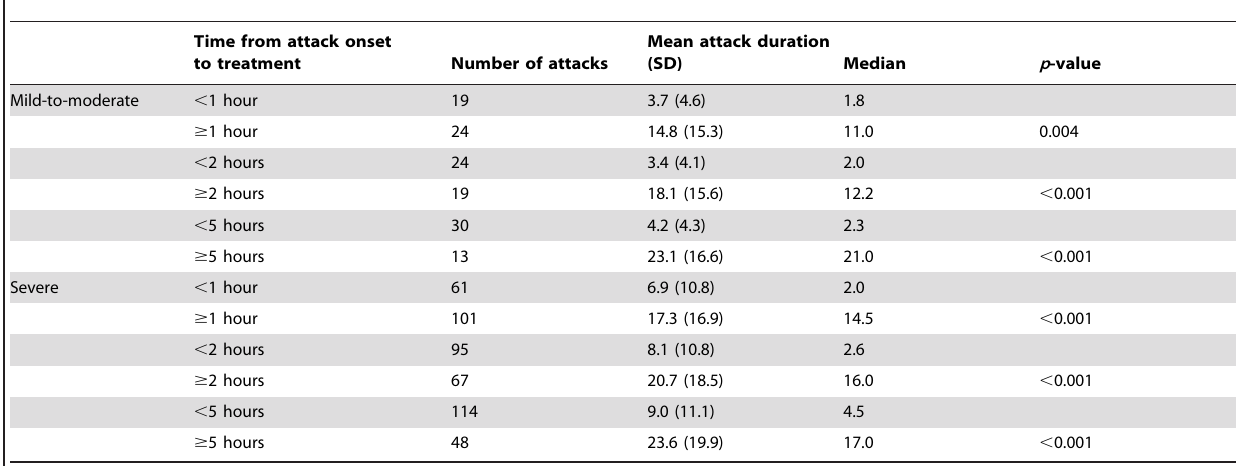
Table 5. Early treatment with icatibant and mean attack duration by attack severity.